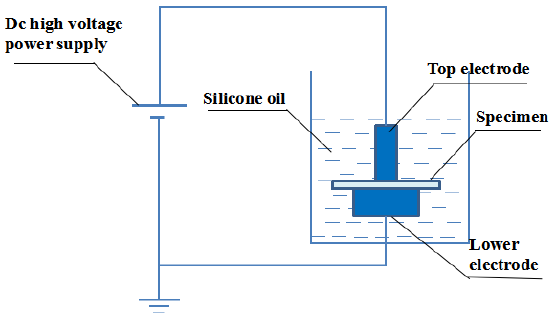
Figure 2. Schematic diagram of the breakdown strength test system.